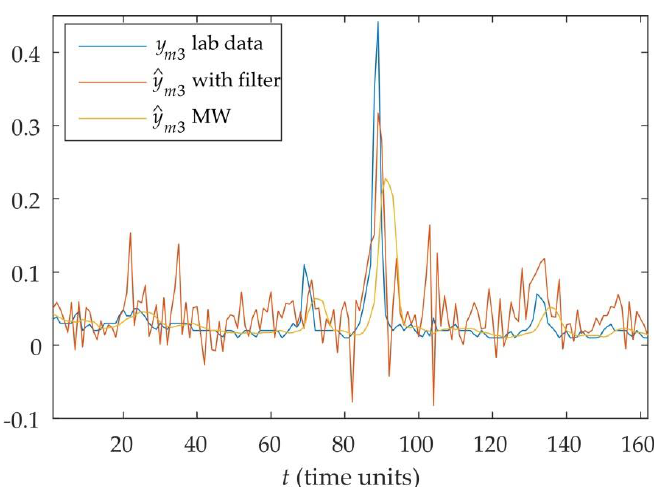
Figure 12. Estimation of y m 3 .